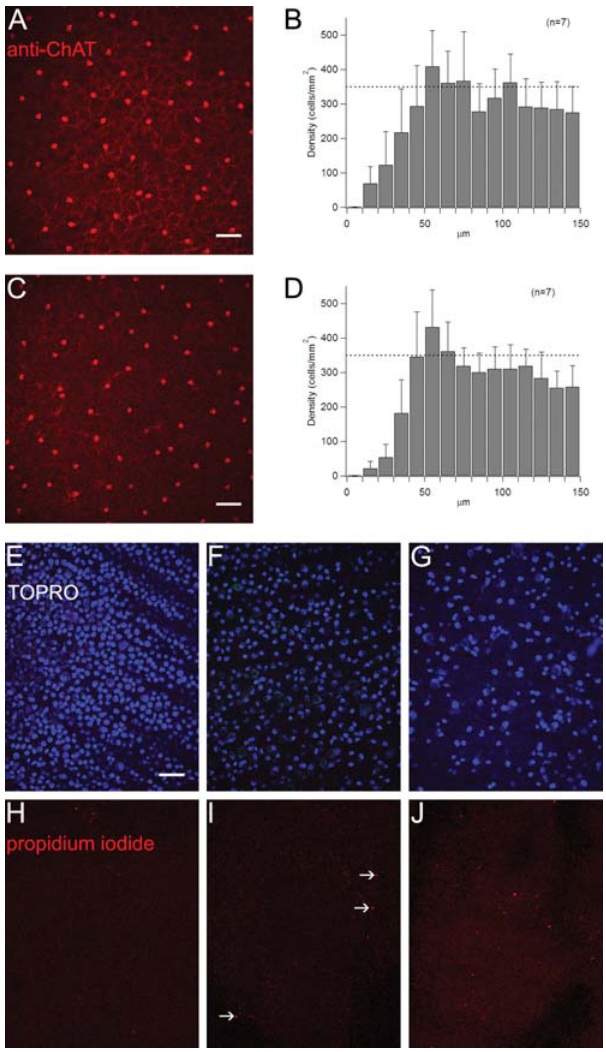
Figure 2. Viability of rabbit retina after six days of incubation. (A) , Typical piece of rabbit retina stained with an antibody against ChAT (red) six after six days of incubation (focus on the ganglion cell layer). Seven such fields were measured to arrive at a density recovery profile ( B ) for starburst amacrine cells. Scale bar for A & C, 50 m m. (C) , matched field with focus on the inner nuclear layer (OFF starburst amacrine cells). (D) , density recovery profile for starburst amacrine cells in the INL. (E, F, and G) , ganglion cell layer of rabbit retina incubated for six days stained for dead cells (propidium iodide, red), cells in the process of apoptosis (YO-PRO, bright green) and counterstained with the nuclear dye TOPRO (blue). No dead or dying cells are visible in the ganglion cell layer in central retina (panel E), mid-periphery (panel F), and peripheral retina (panel G). (H, I, and J) show matched fields with the focus on the photoreceptor cell bodies. Several cells are labeled by their in- corporation of propidium iodide (arrows), indicating cell death in the photoreceptor layer. Scale bar for panels E–J, 50 m m.